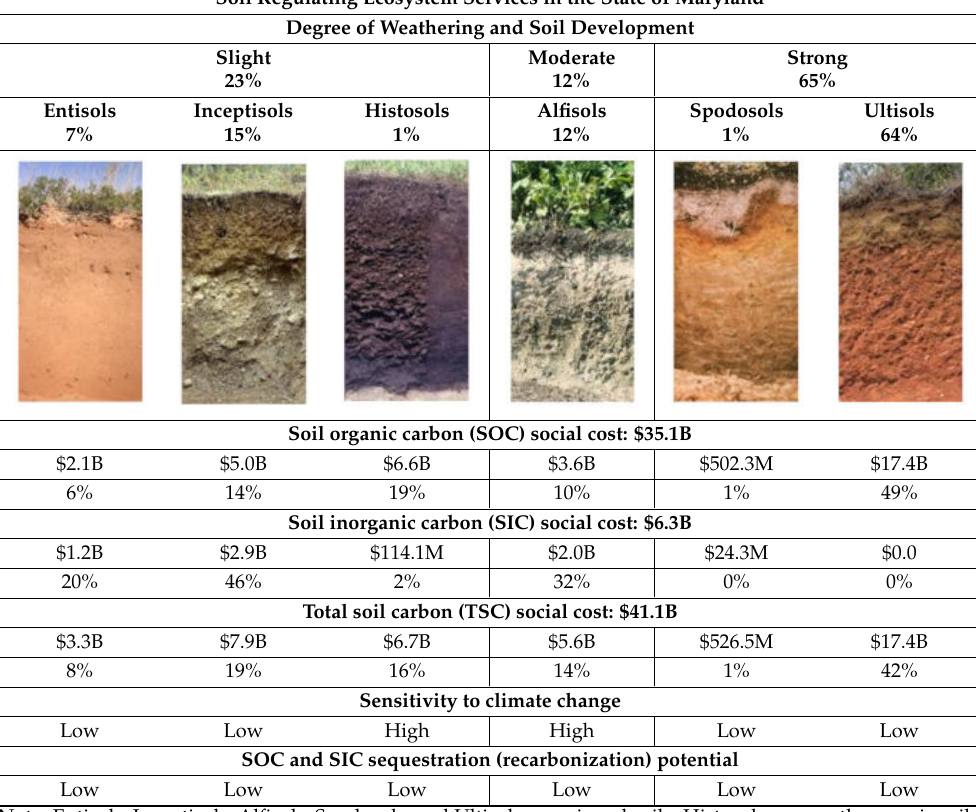
Table 5. Soil carbon regulating ecosystem service distribution for Maryland, USA (photos courtesy of USDA/NRCS [21]). Degree of Weathering and Soil